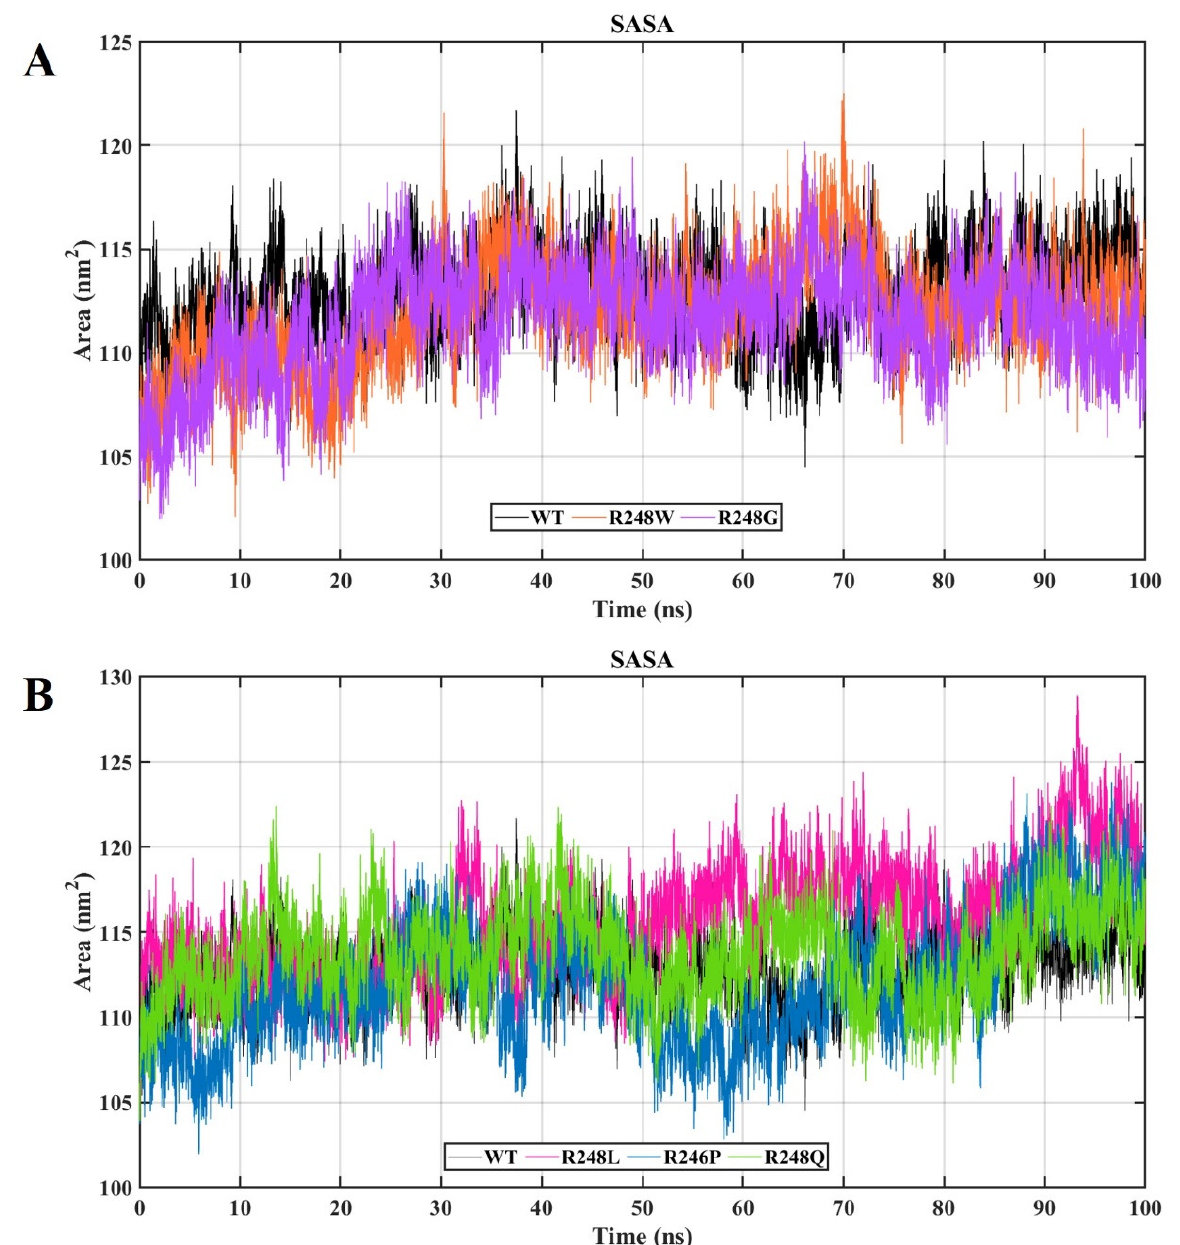
Figure 5. The SASA plot of the wt-p53–DNA and R248 mutant-p53–DNA complexes. The X and Y axes denote time (ns) and the area (nm 2 ). ( A ) The black color represents the wt-p53–DNA complex, the orange color represents the R248W mutant-p53–DNA complex, and the violet color represents the R248G mutant-p53–DNA complex. ( B ) The black color represents the wt-p53–DNA complex, the pink color represents the R248L mutant-p53–DNA complex, the blue color represents the R248P mutant-p53–DNA complex, and the green color represents the R248Q mutant-p53–DNA complex. Comparing Rg vs. SASA plots for wt-p53–DNA and R248 mutant-p53–DNA com- plexes quantifies two crucial global properties: total size and solvent exposure. We